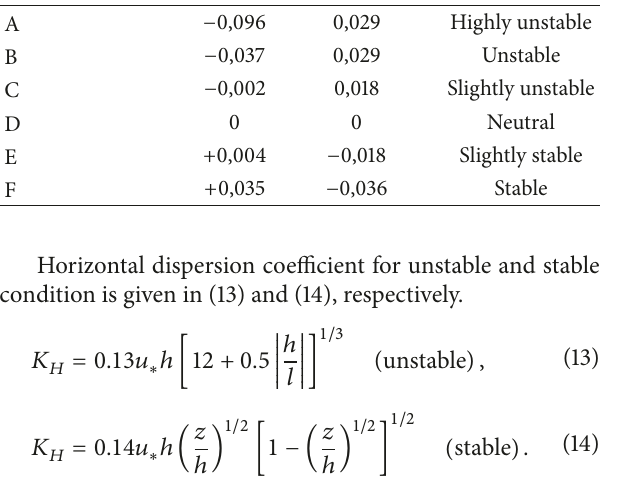
Table 1: Coefficients for Monin-Obukhov length [8]. Pasquill stability class